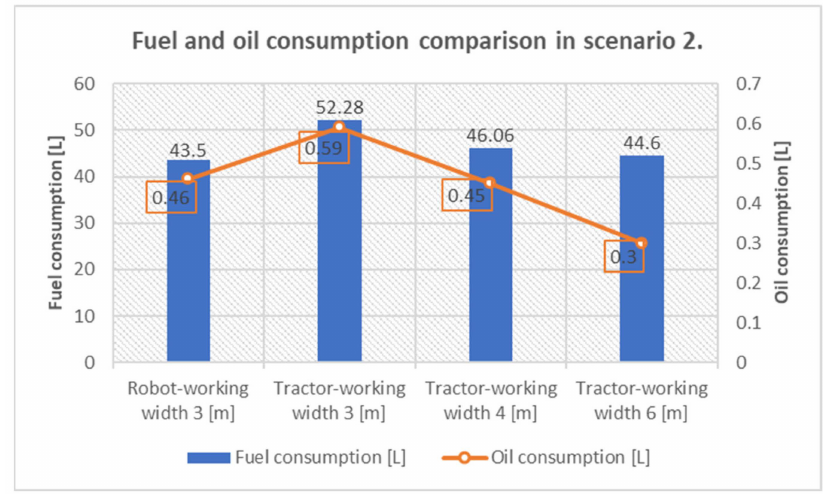
Figure 15. The comparison of fuel and oil consumption between robot and tractor in the second scenario.